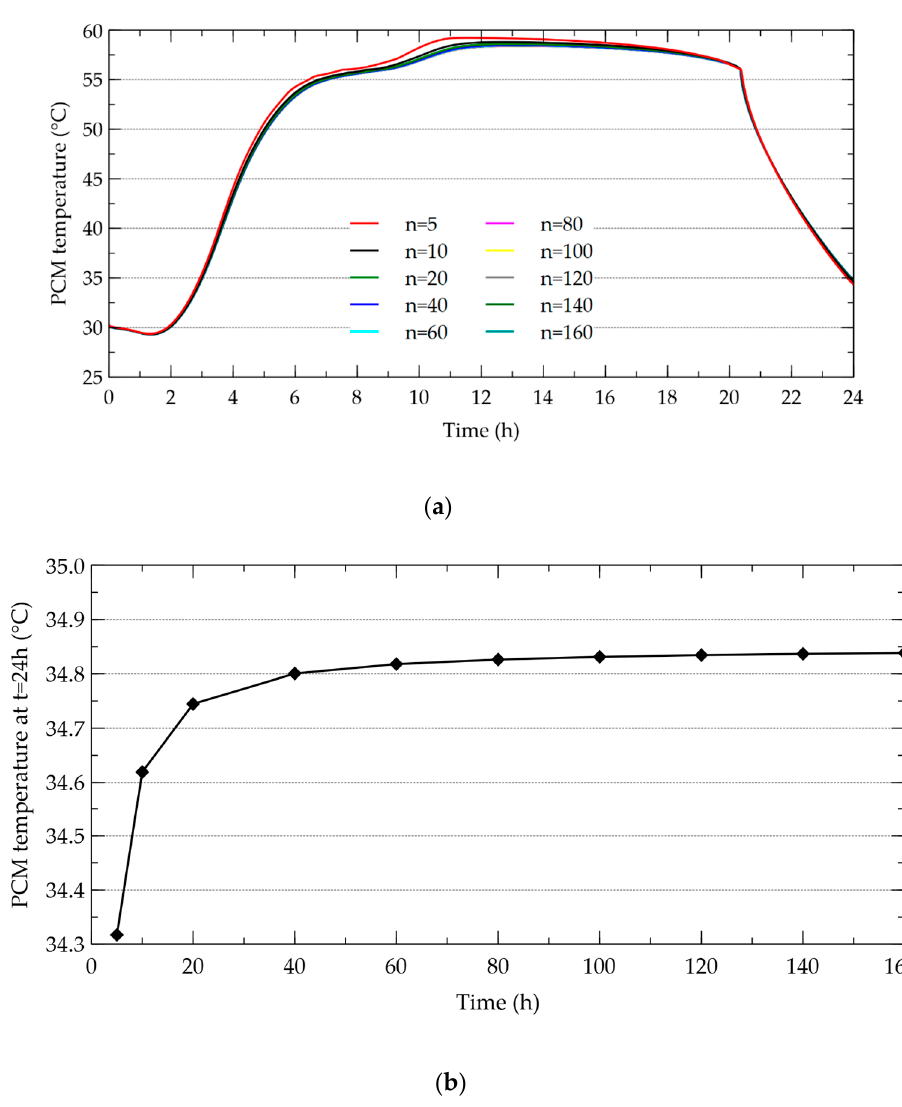
Figure 5. Independent analysis for PCM layers: ( a ) Simulations for different numbers of PCM layers. ( b ) Temperature at 24:00 h for different numbers of PCM layers. ( b ) Temperature at 24:00 h for di ff erent numbers of PCM layers.